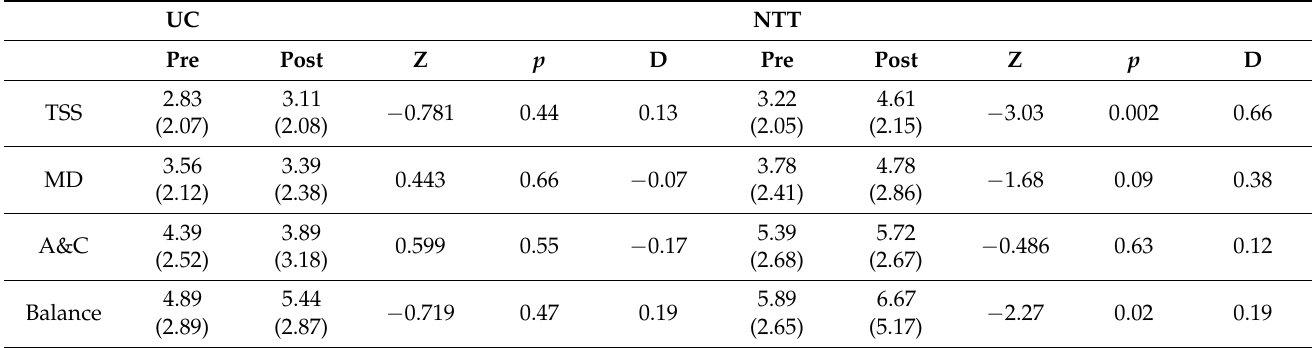
Table 3. Mean (SD) pre and post-intervention standard scores on MABC-2 for UC (n = 18) and NTT group (n = 18). (t-values, p -values, and Cohen D effect size). TSS: Total standard score; MD: manual dexterity; A&C: aiming and catching. Z: z-value Wilcoxon; p : p -value; d: Cohen d; UC; usual care; NTT: neuromotor task training.